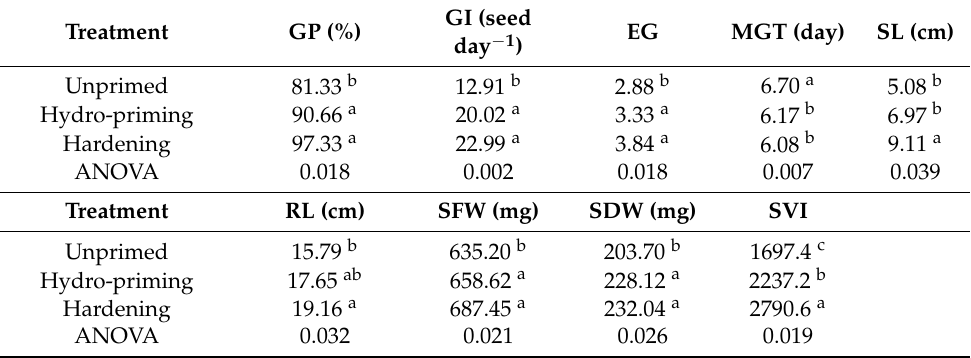
Table 3. Germination percentage (GP, %), germination index (GI, seed day − 1 ), energy of germination (EG), mean germination time (MGT, day), shoot length (SL, cm), root length (RL, cm), seedling fresh weight (SFW, mg), seedling dry weight (SDW, mg) and seedling vigor index (SVI) of maize seeds as affected by seed priming